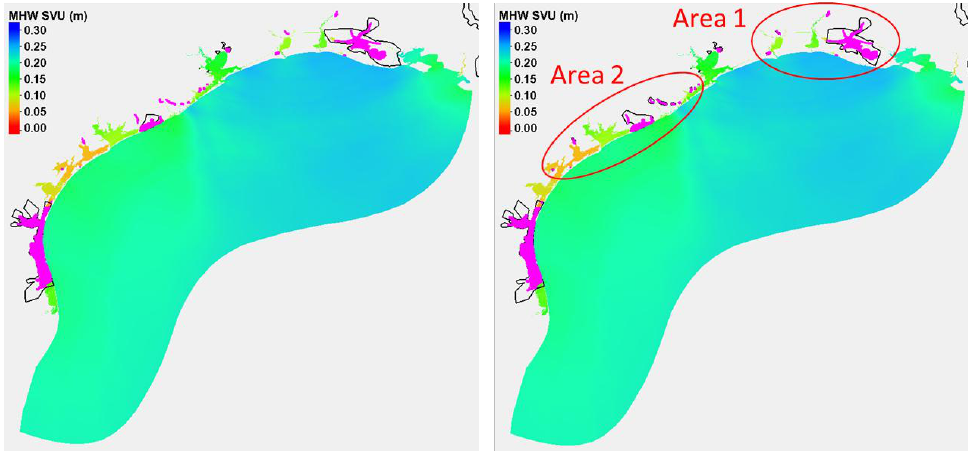
Figure 13. Non-tidal polygons (closed black lines) before ( left ) and after ( right ) the upgrade. Modeled non-tidal grid points are marked as pink dots. Area 1 and Area 2 (within the closed red lines) are the two areas which had major adjustments in the non-tidal upgrade.